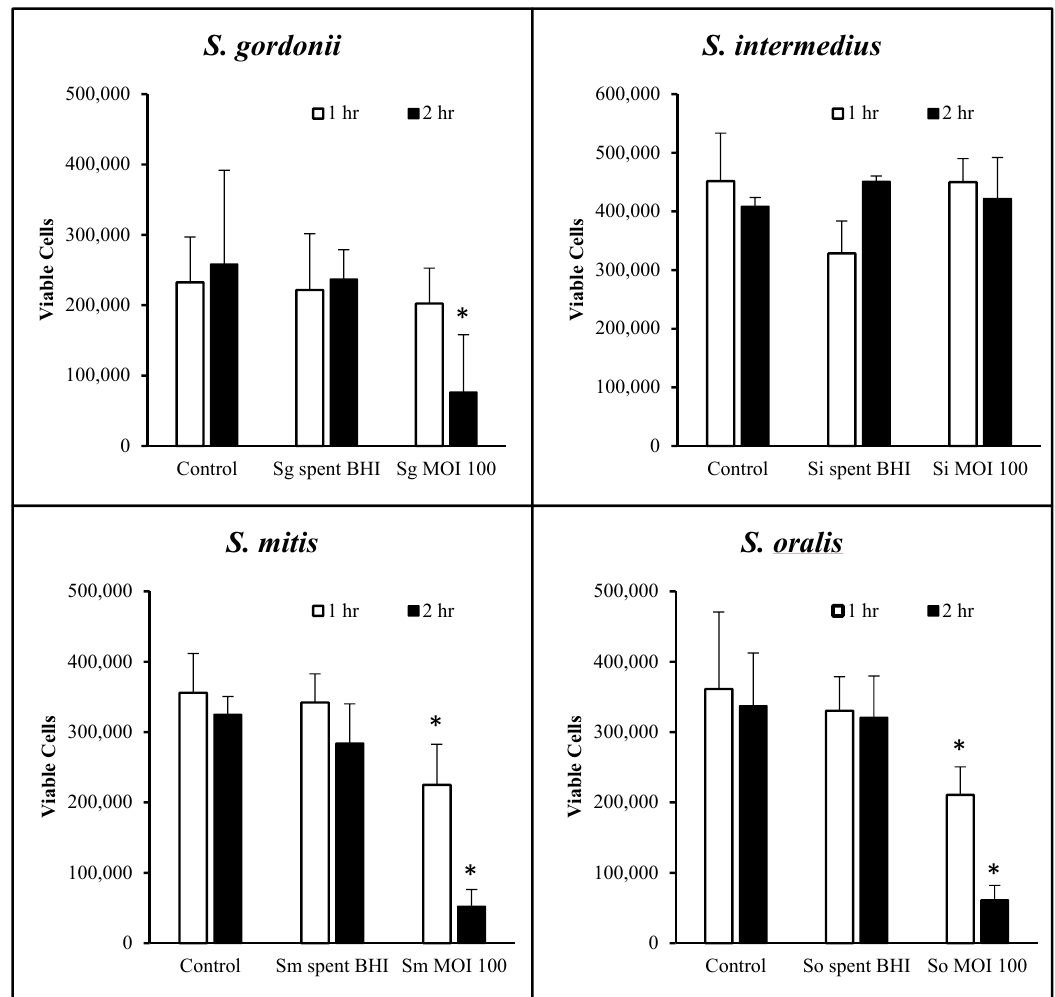
Figure 3. Viability of OKF6/Tert cells following exposure to commensal streptococci. Cell viability reflects the number of live OKF6 cells two days after exposure to S. gordonii (Sg), S. intermedius (Si), S. mitis (Sm), or S. oralis (So) or their spent media. Live cells were quantified using the trypan blue exclusion assay. Graphs represent the average and SD of four independent experiments. * = p < 0.05 compared to control.